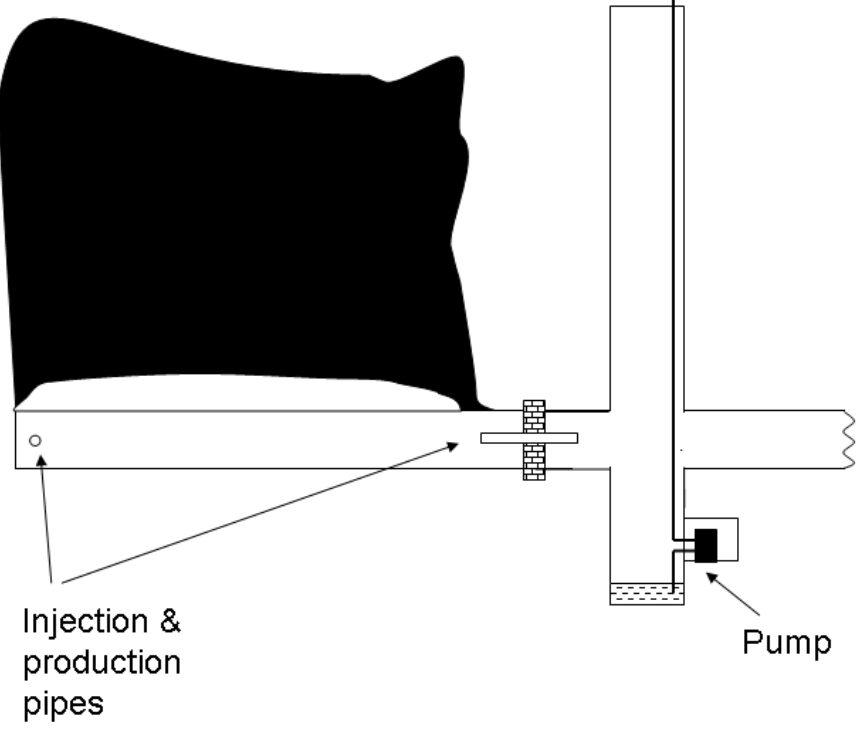
Figure 5. Schematic of the stream experiment according to reference